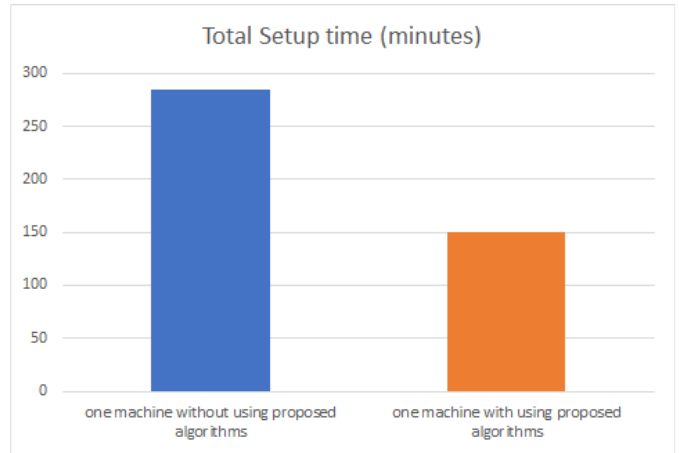
Figure 7. The performance of total setup time for one machine.